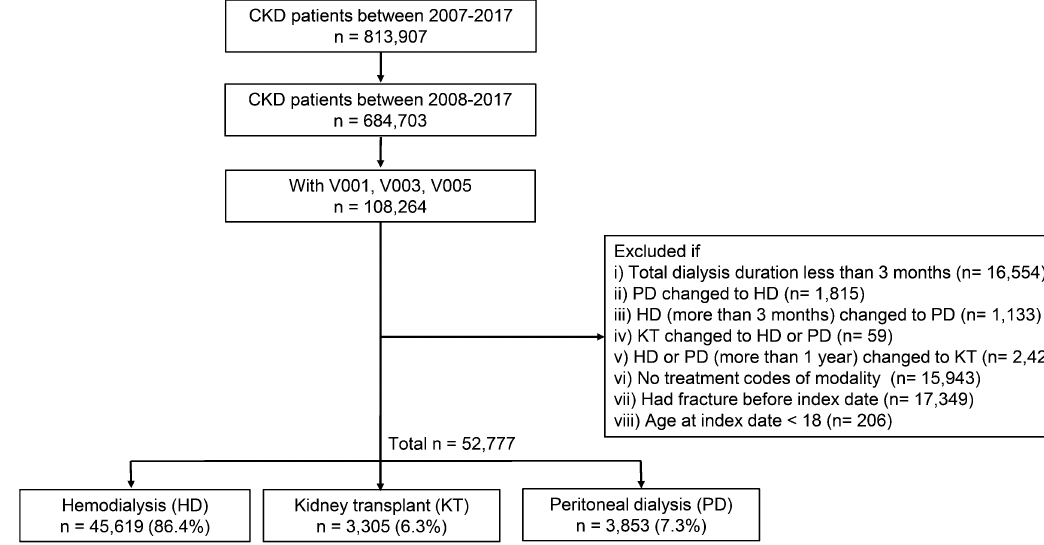
Figure 1. Flow chart outline of the study design. CKD chronic kidney